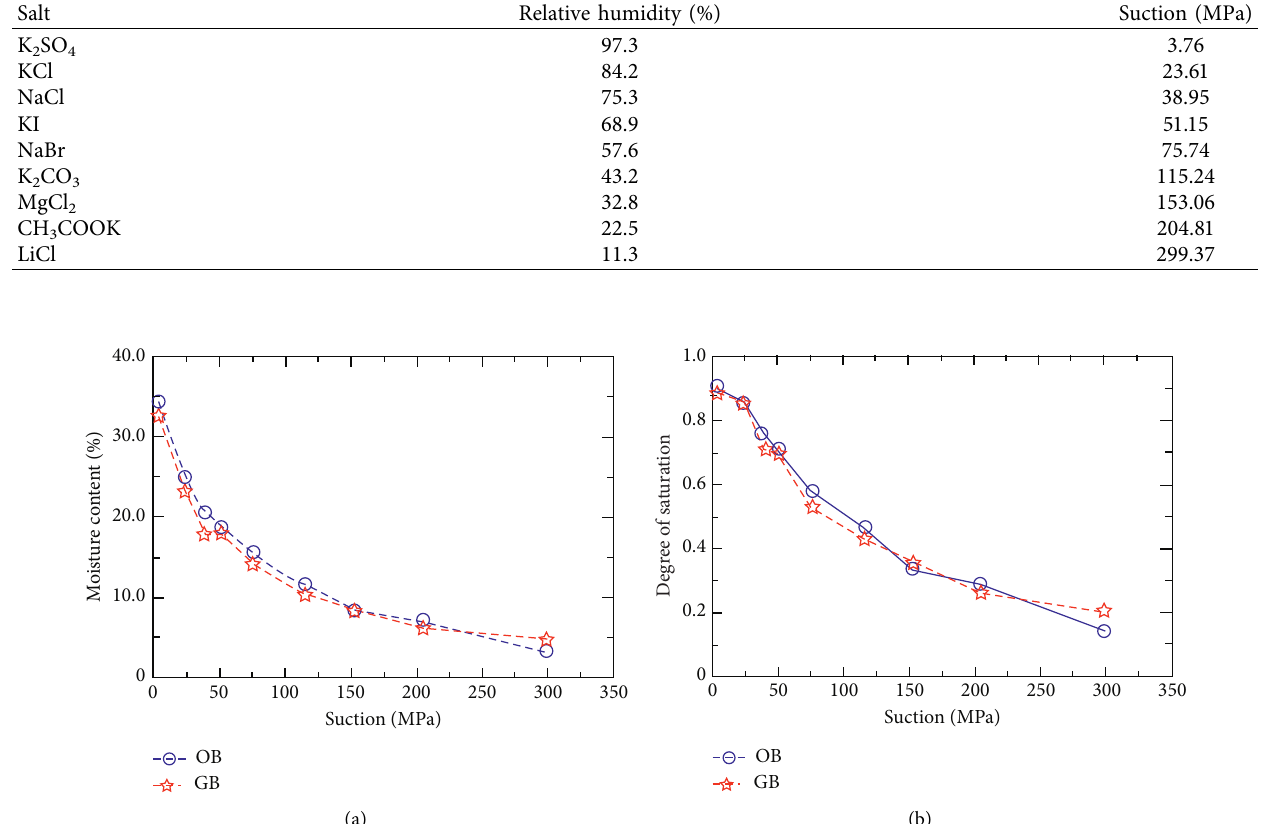
Table 3: Type of salt solution, relative humidity, and corresponding suction value (25 ° C).